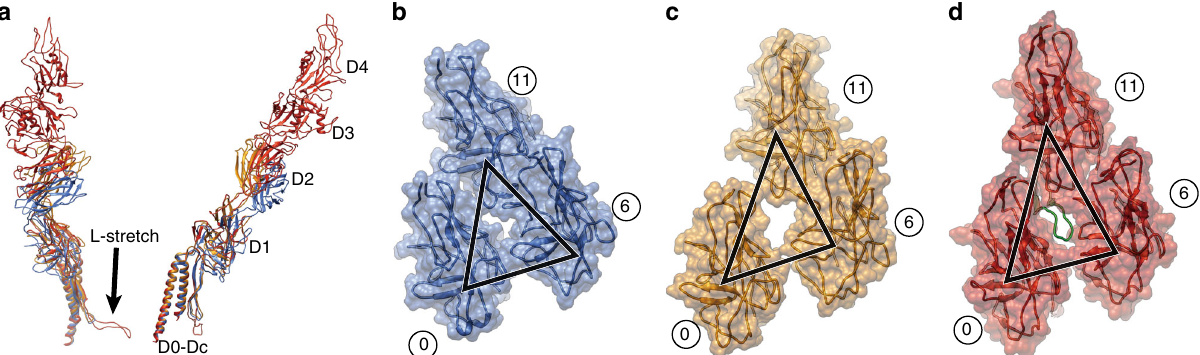
Fig. 6 The gap formed by three D1 domains of subunit 0, 6, and 11. a Structural comparison of FlgE from Salmonella (blue and yellow) and Campylobacter (red, PDB-ID:5JXL) by superposition of domain D0. b – d The gaps formed by three D1 domains around the shortest ( b ) and the longest ( c ) proto fi lament of the native supercoiled hook of Salmonella , and of the straight hook of Campylobacter ( d ). In d , the loop in green fi lling the gap is the tip of the L-stretch of domain Dc of